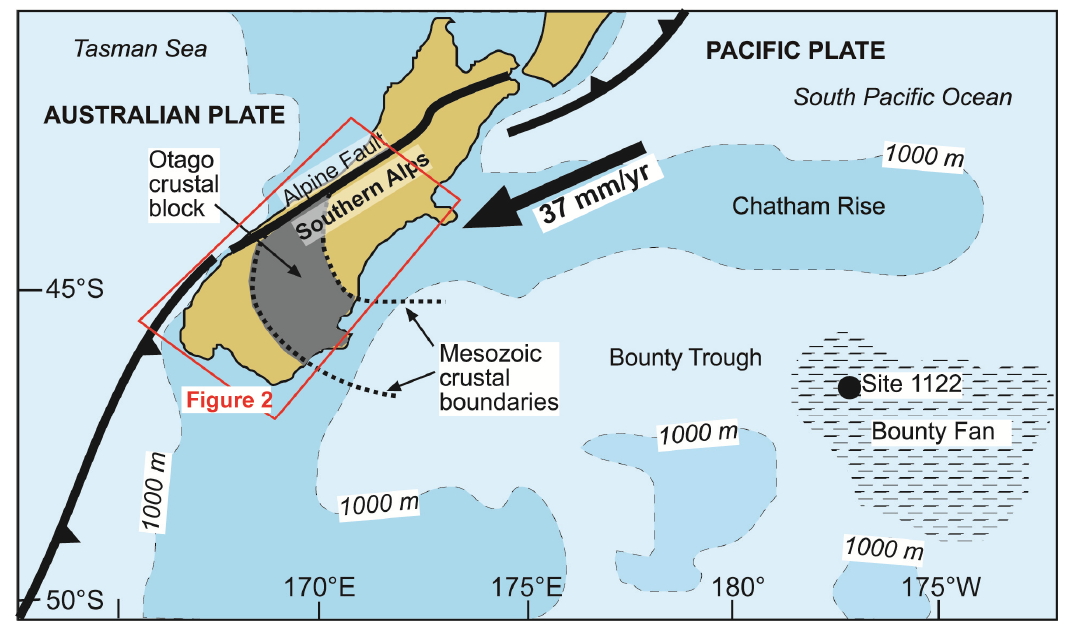
Figure 1. Tectonic setting of the Pacific/Australian plate boundary in Southern New Zealand. The relative plate motion vector is from DeMets et al. [11]. The Otago schist block is highlighted. ODP (Ocean Drilling Program) site 1122 is located on the Bounty Fan approximately 1200 km east of